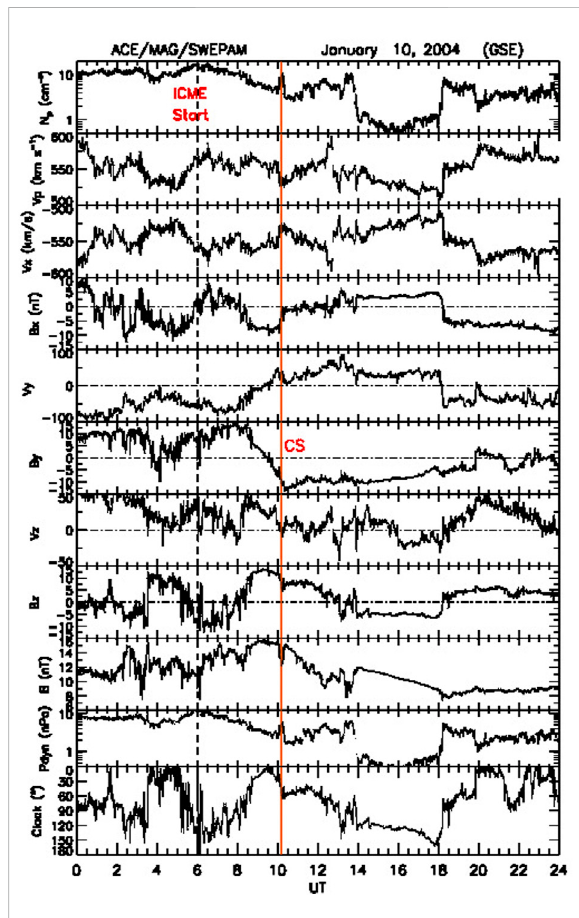
FIGURE 2 ACE observations on 10 January 2004. From top to bottom: the proton density, bulk speed, (pairwise) components of fl ow and magnetic fi eld, the dynamic pressure in nPa, and the IMF clock angle, i.e., the polar angle in the GSM YZ plane. The dynamic pressure includes the alpha-particle contribution. The vertical red line shows the time of the current sheet which we discuss